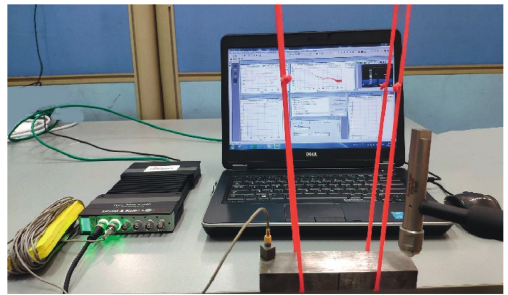
Figure 7: Hammering excitation detection platform.